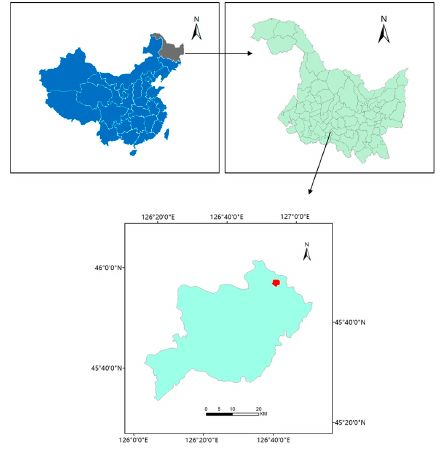
Figure 1. The map of the experimental site.